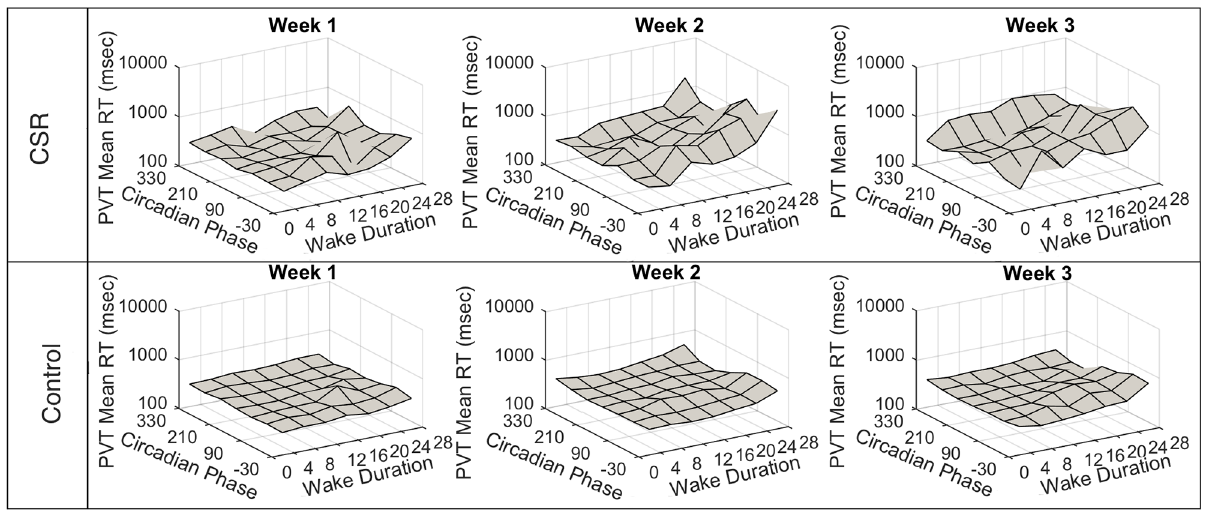
Fig 2. PVT scores by Circadian Phase and Wake Duration . Mean reaction times (RT) on the Psychomotor Vigilance Task (PVT) are plotted as a function of Circadian Phase (zero degrees is the fit melatonin maximum) and Wake Duration (hours elapsed in scheduled wake episode). The top panel contains data from the Chronic Sleep Restriction (CSR) condition. The bottom panel contains data from the Control condition. Each column shows one week (four 42.85-h “ days ” ) of data.